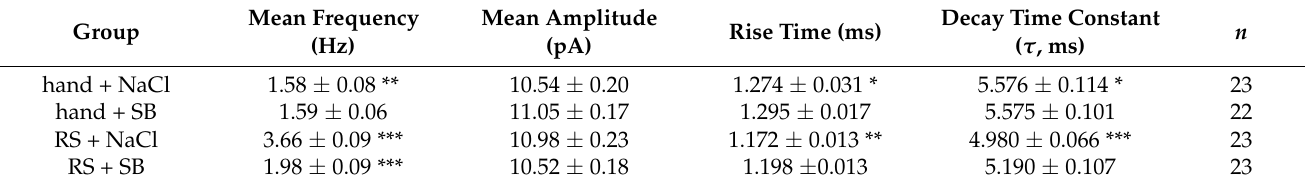
Table 5. Effects of restraint and SB 269970 on parameters characterizing sEPSCs (mean ±